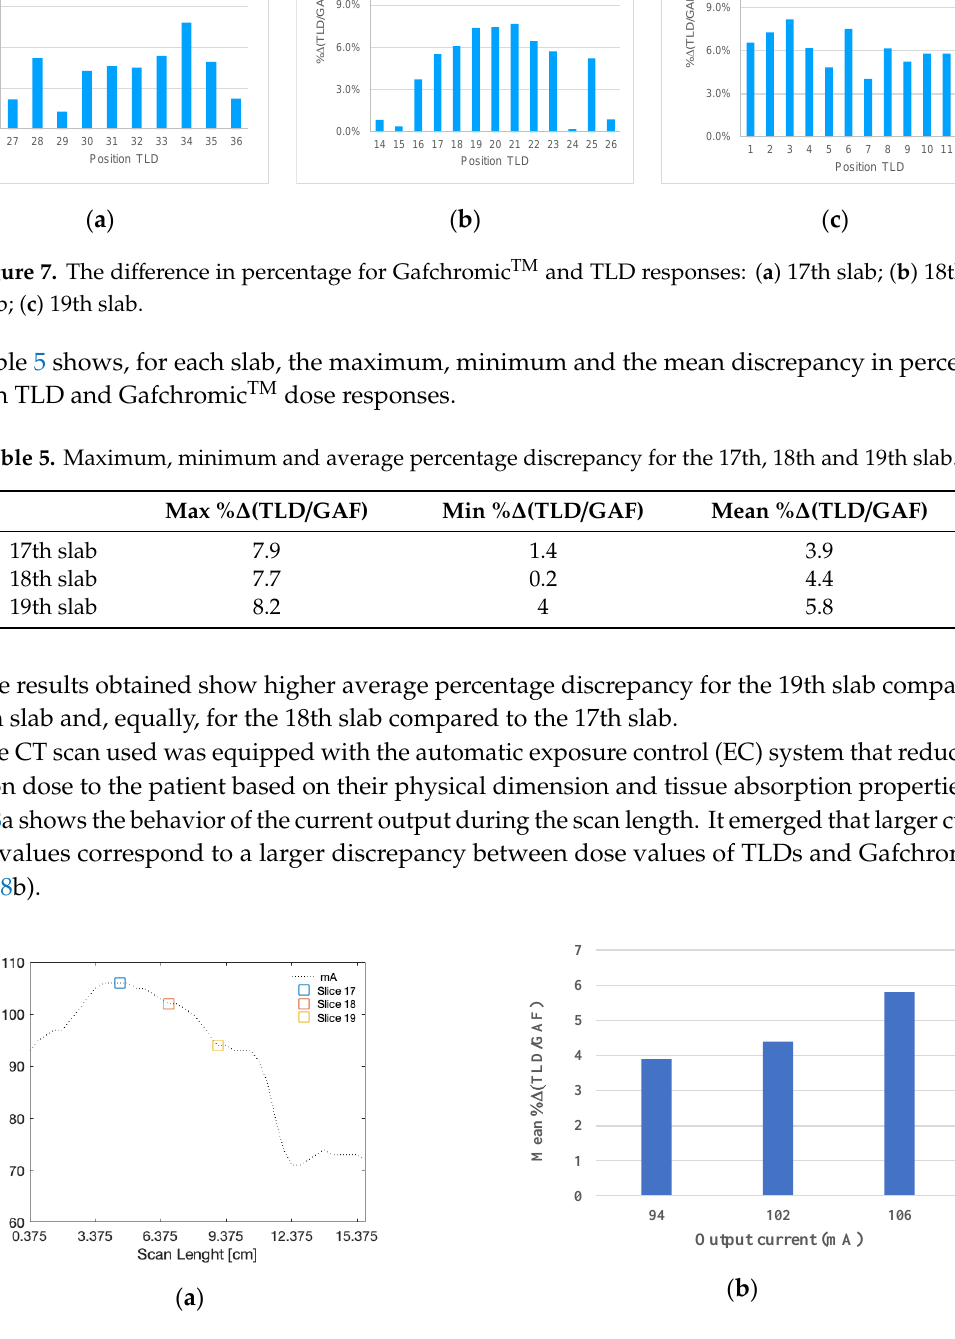
Figure 8. ( a ) Current output vs. scan length; the colored squares correspond to the film position between the phantom slabs; ( b ) mean slice-by-slice %Δ(TLD/GAF) correction factors vs. CT current output.